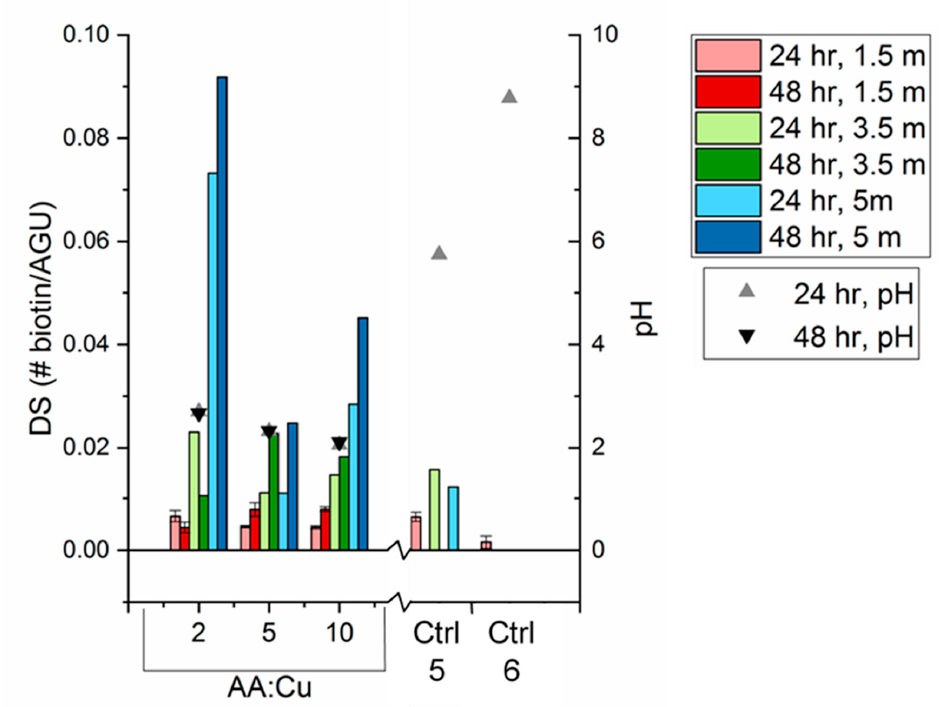
Figure 6. Degree of substitution of biotin on cellulose nanofibers, calculated from HABA colorimetric assay, increases with pH of reaction conditions and aging over a period of 5 months. All samples were stored in air for 5 months, and portions of each sample were assayed at 1.5, 3.5, and 5 months. Full reaction samples were tested at 2, 5, and 10 ascorbic acid-to-copper ratio (AA:Cu) for 24 and 48 h reaction times. All controls were quantified, and only Controls 5 and 6, shown here, had detectable biotin.